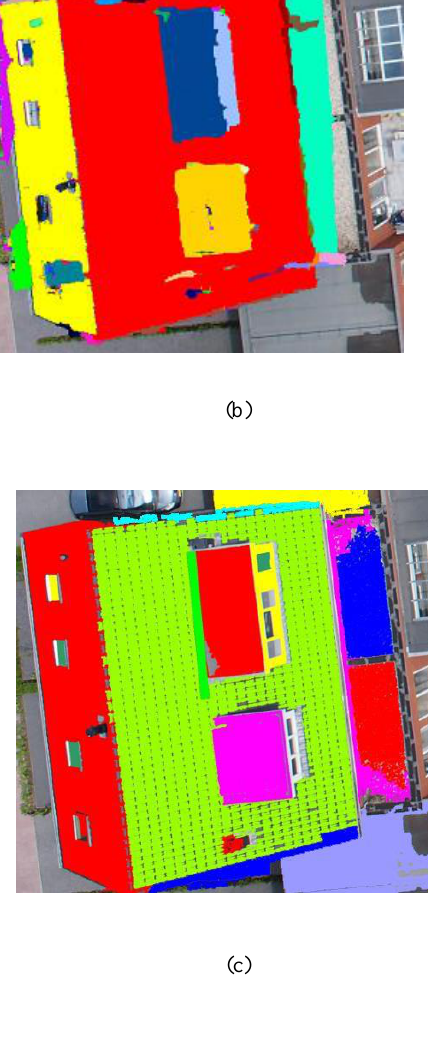
Figure 8. (a) & (d): Buildings in UAV image for segmentation, (b) & (e): projected 3D segments over the images of (a) & (d) respectively, and (c) & (f): finally segmented images using the developed